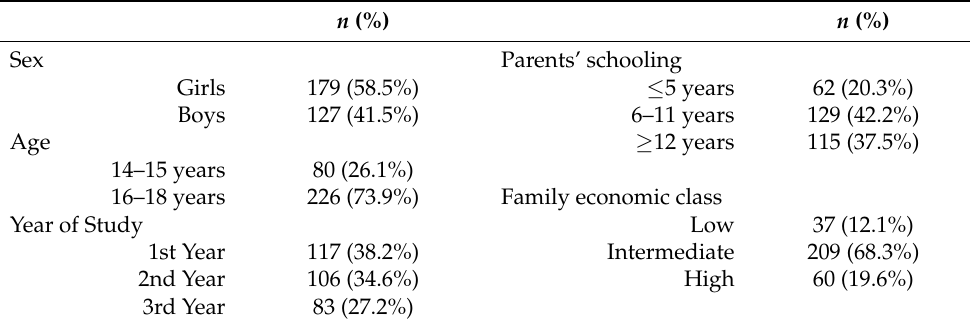
Table 1. Demographic data of the selected sample in the study ( n =